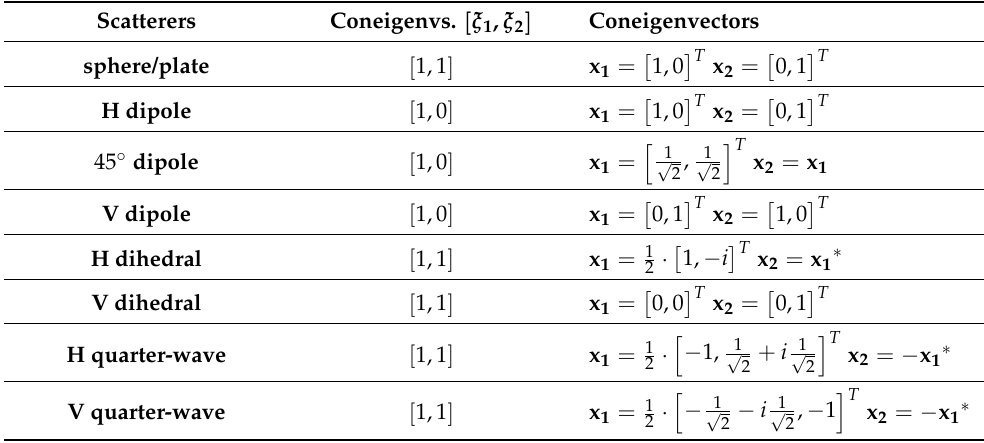
Table 2. Coneigenvalues and coneigenvectors determined through the RR method for some of the elementary scattering